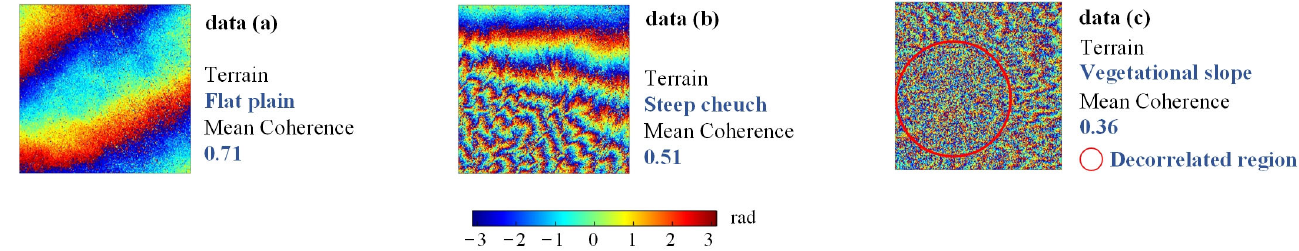
Figure 8. Real interferograms for three different coherence and topographic conditions. ( a ) An interferogram from a flat terrain, ( b ) An interferogram from a steep terrain, ( c ) An interferogram from an area with high vegetation coverage.